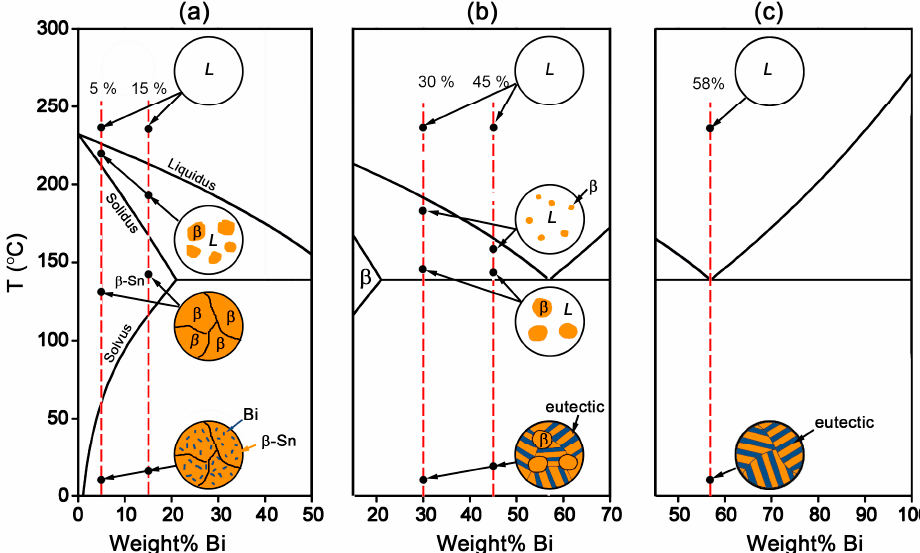
Figure 3. Microstructural evolution in Sn-Bi solder system: ( a ) solid solution Sn-Bi; ( b ) hypoeutectic Sn-Bi and ( c ) eutectic Sn-Bi.